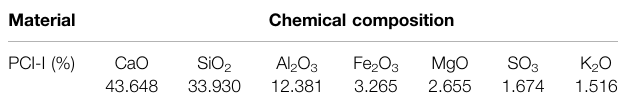
TABLE 2 | Main chemical composition of